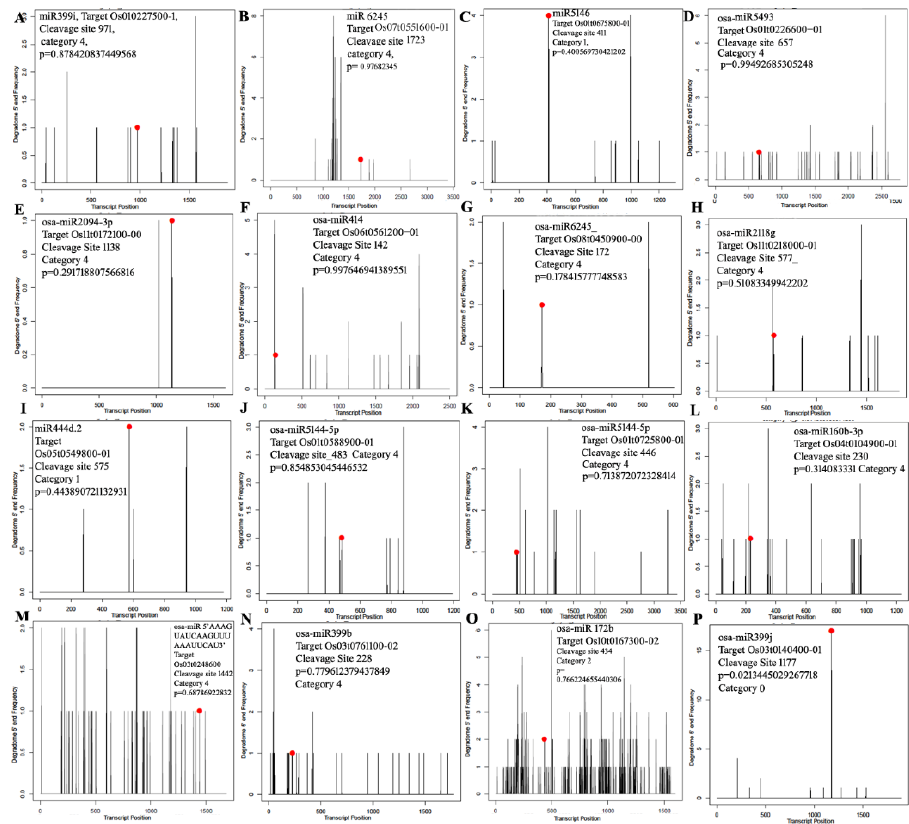
Figure 4. Target plot (t-plot) of 16 targets of miRNA categories including the DEms, neutrally regu- lated miRNAs, and uniquely expressed miRNAs. Degradome tags including the miRNA, transcript ID, cleavage site, and degradome p -value are indicated at top of each t-plot. T-plots were built on the basis of transcript nucleotide vs. degradome 5 ′ end frequency. The black line represents cleaved products, and the red dot indicates the cleavage site (CS) predicted due to miRNA. The categories (0–4) were based on the relative abundance of the tags at the target sites. T-plot indicating cleavage of ( A ) Os010227500-1 by miR399i , ( B ) Os07t0551600-01 by miR6245 , ( C ) Os01t0675800-01 by miR5146 , ( D ) Os01t0226600-01 by miR5493 , ( E ) Os11t0172100-00 by miR2094-3p , ( F ) Os06t0561200-01 by miR414 , ( G ) Os08t0450900-00 , ( H ) Os11t0218000-01 by miR2118g , ( I ) Os05t549800-01 by